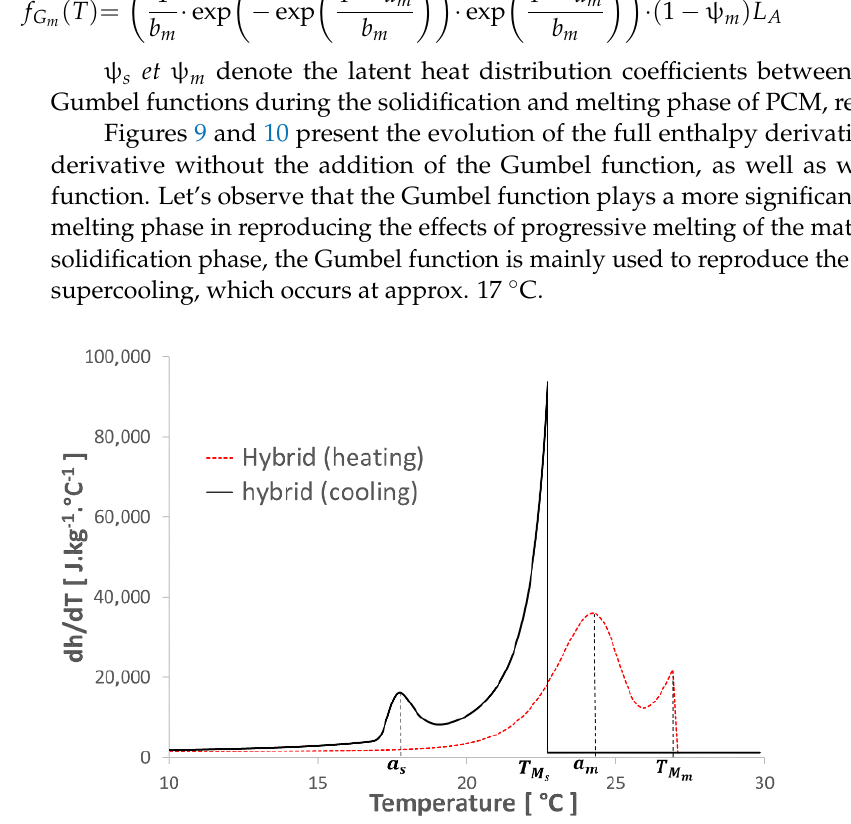
Figure 10. Evolution of the enthalpy derivate of the binary and Gumbel’s functions used to create the hybrid model. This undercooling stems from the fact that the PCM used in this study is a mixture of two fatty acid-based PCMs [49], each with distinct thermal behavior. A difference of about 4% exists between the liquid fraction variation at the beginning of heating and at the end of cooling (Figure 11), as observed by K. Merlin [49] on several PCMs as well. The author assumed that this phenomenon was due to either incomplete melting of the mate- rial or measurement errors. An error analysis related to experimental uncertainties is car- ried out and detailed in Section 5.2.